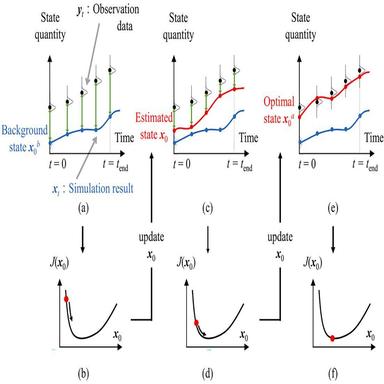
Schematic flowchart of 4DVar for finding the optimal state vector, x0 a , by minimizing the cost function, J(x0), which qualifies the misfit between the estimation results of the true states and observation data from t = 0 to t = tend, as well as the discrepancy between the estimation results of the true states and background state. As the first step (a), an arbitrary initial state is used as an initial guess of x0, which is called the background state vector x0 b , to perform the simulation. As the second